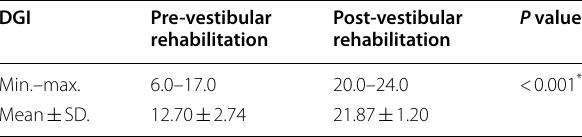
Table 3 Comparison of (DGI) scores before and after